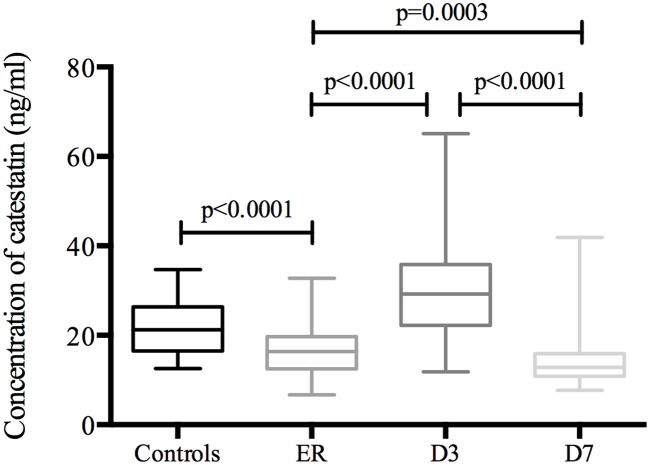
Plasma catestatin levels in controls and patients during the first week after AMI.Box plots showing the distribution of concentrations of plasma catestatin at different time points (n = 100). Boxes specify inter-quartile ranges; the horizontal bars inside the boxes indicate medians; the upper and lower whiskers get to the most distant value within the 95% of the distribution. The p-values for the comparison of the groups are also indicated. Control (21.8±6.3ng/ml); ER: emergency room (16.7±5.4ng/ml); D3: the third day after AMI (30.9±12.1ng/ml); D7: the seventh day after AMI (13.9±5.2ng/ml).